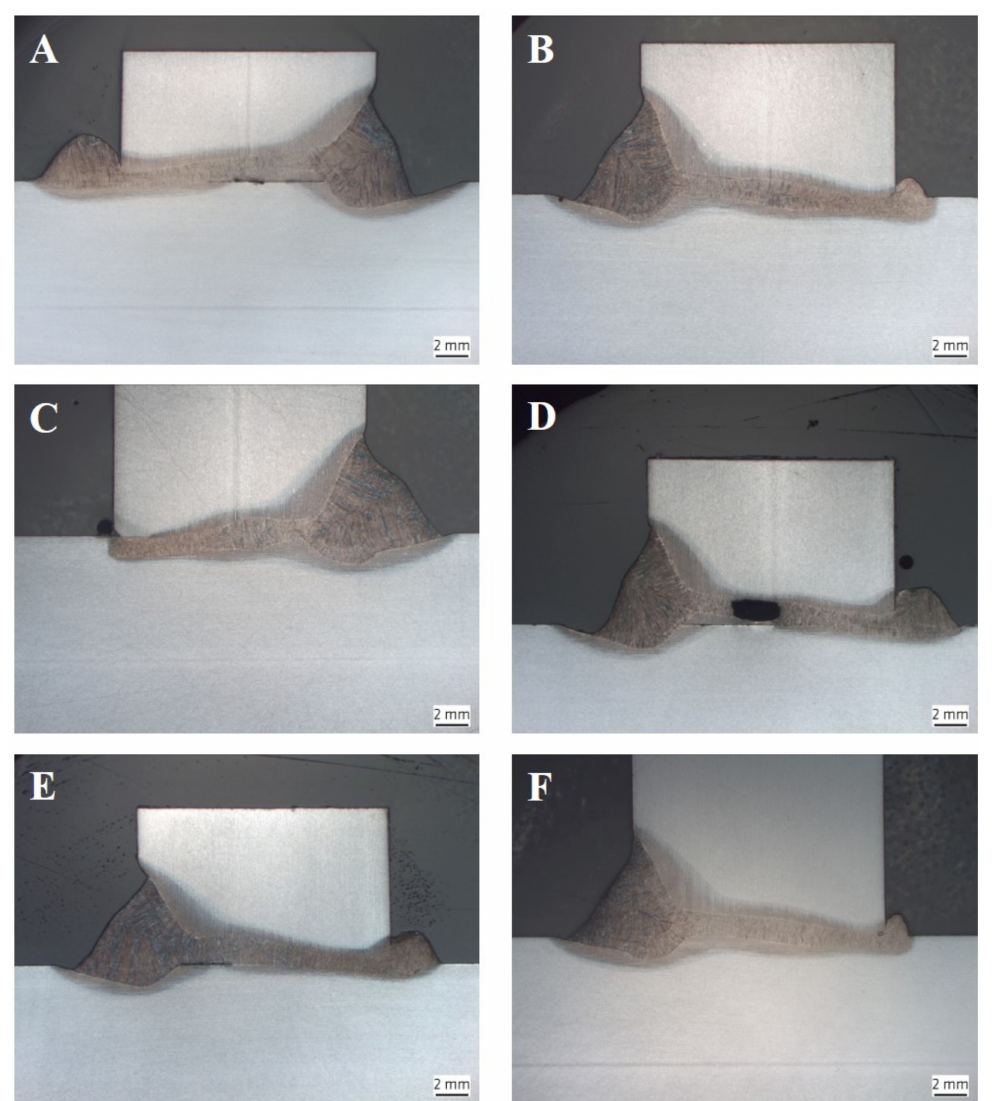
Figure 5. Cross-sections of one side HLAW T-joints welded under conditions ( A – F ), as indicated in Table